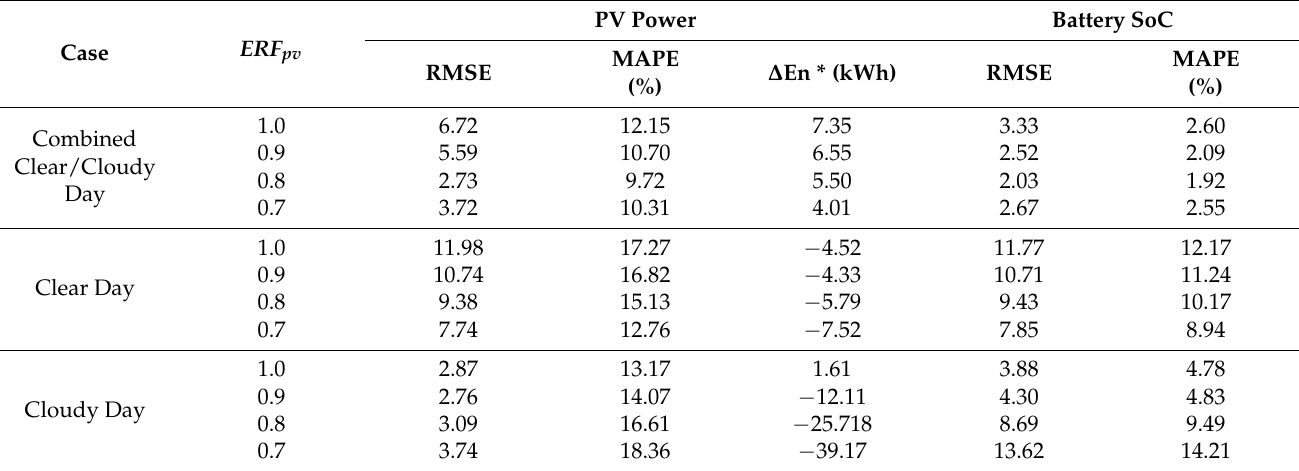
Table 7. The RMS and MAPE indices for simulation models with different ERF pv values on the considered